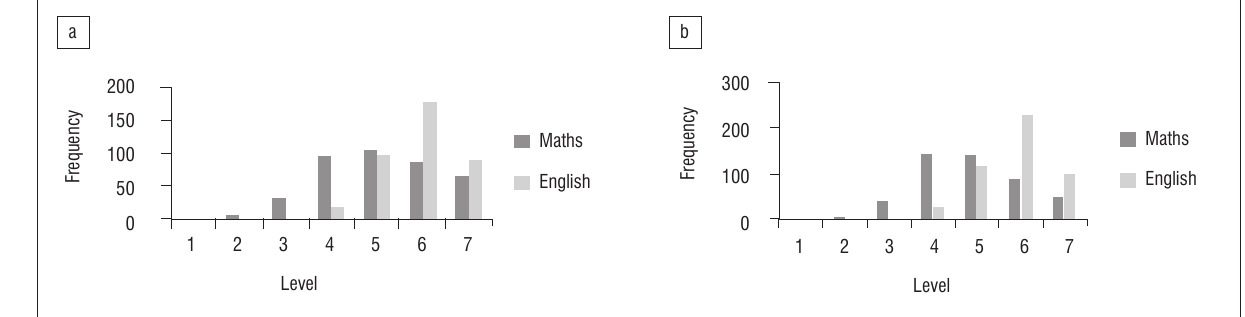
Figure 2: NQF Mathematics and English proficiency levels for Math150 students who (a) completed the quiz and (b) did not complete the